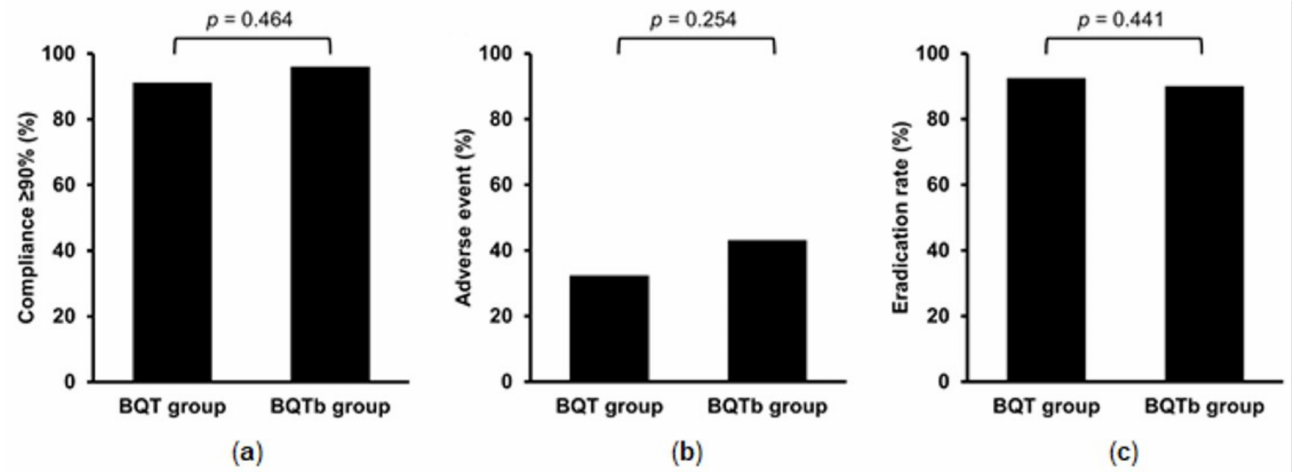
Figure 2. Comparison of factors associated with eradication therapy. ( a ) The proportion of patients with adherence ≥ 90% ( n = 119); ( b ) adverse event rates ( n = 119); ( c ) eradication rate for bismuth quadruple therapy four times a day (BQT group) and twice a day bismuth quadruple therapy (BQTb group).